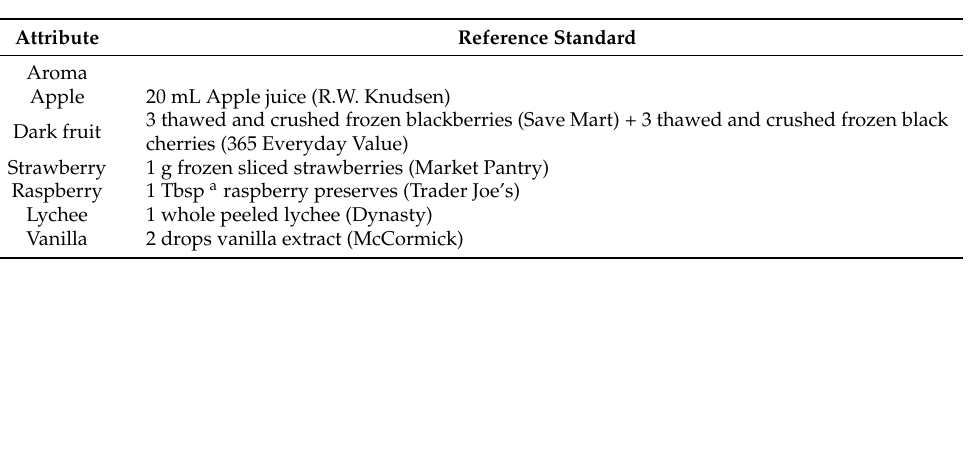
Table 3. Attributes and corresponding reference standards for the Cabernet Sauvignon descriptive analysis